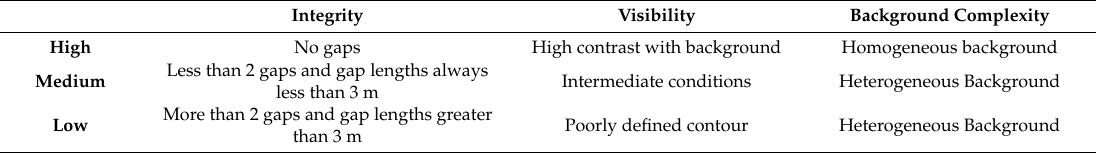
Table 5. Score categories used for the assessment of integrity, visibility and background complexity of processed the linear traces in